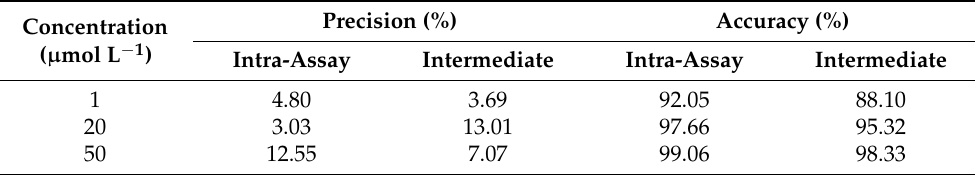
Table 3. Precision and accuracy data ( n =